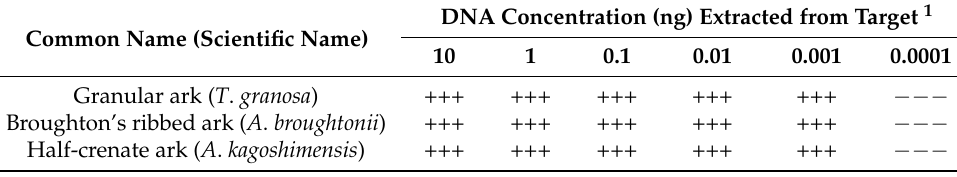
Table 4. Detectability of ultrafast PCR with various target species